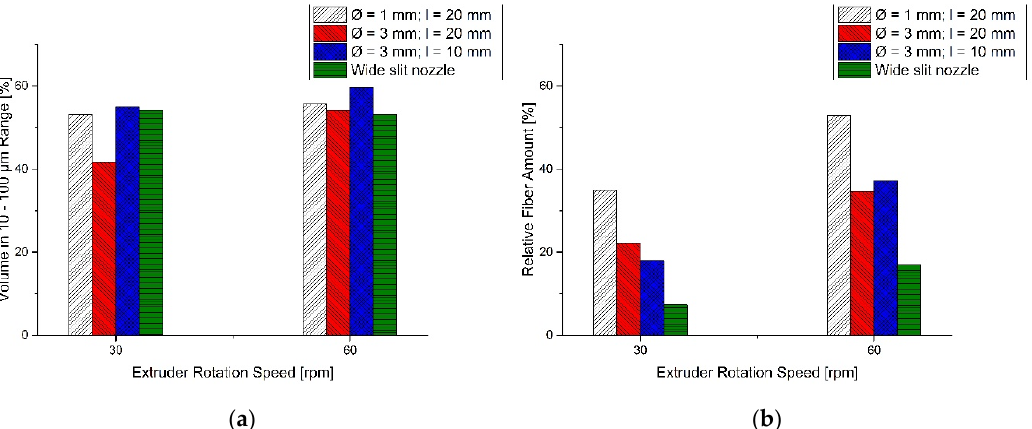
Figure 4. (a) Percentage of total particle volume with a size that lies in the range of 10–100 µm in dependence of nozzle selection and extruder rotational speed; (b) Amount of PBT that comes out of the extruder in fibrous state, relative to total PBT blend content.